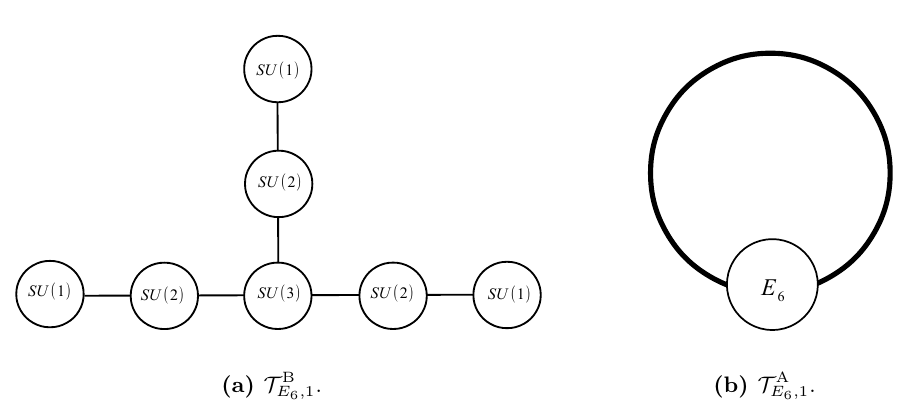
Figure 8. The (cid:12)ber-base duality for the case g = E 6 . The nodes in diagram (a) are connected by free bi-fundamental hypermultiplets while the adjoint (cid:12)eld of diagram (b) is an E 6 conformal matter